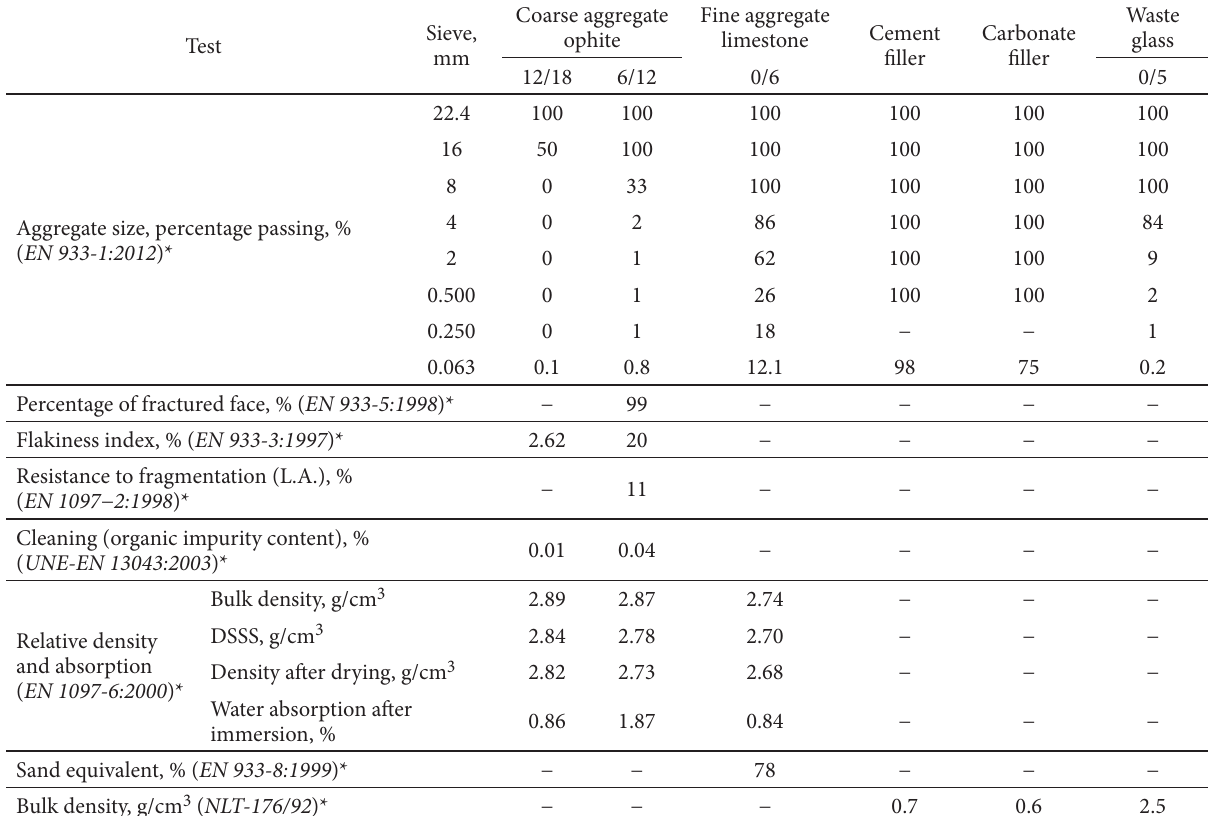
Table 1. Reference values of the aggregates, mineral dust, and waste